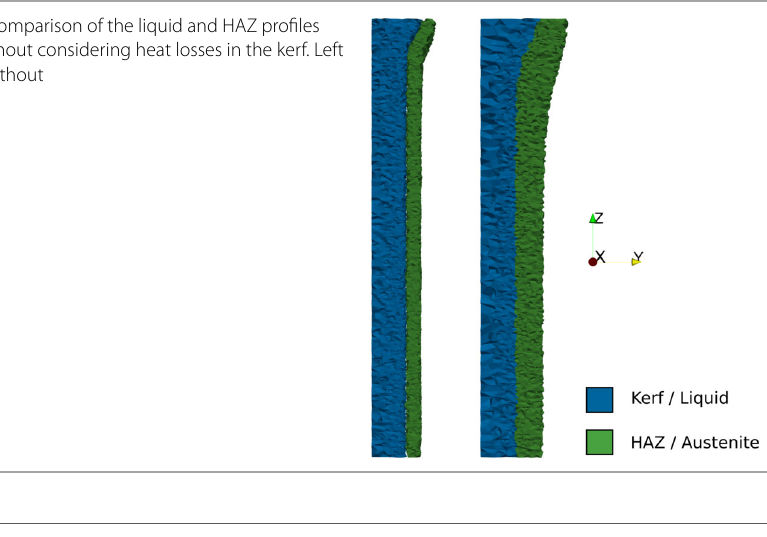
Figure 10 Comparison of the liquid and HAZ profiles with and without considering heat losses in the kerf. Left with, right without